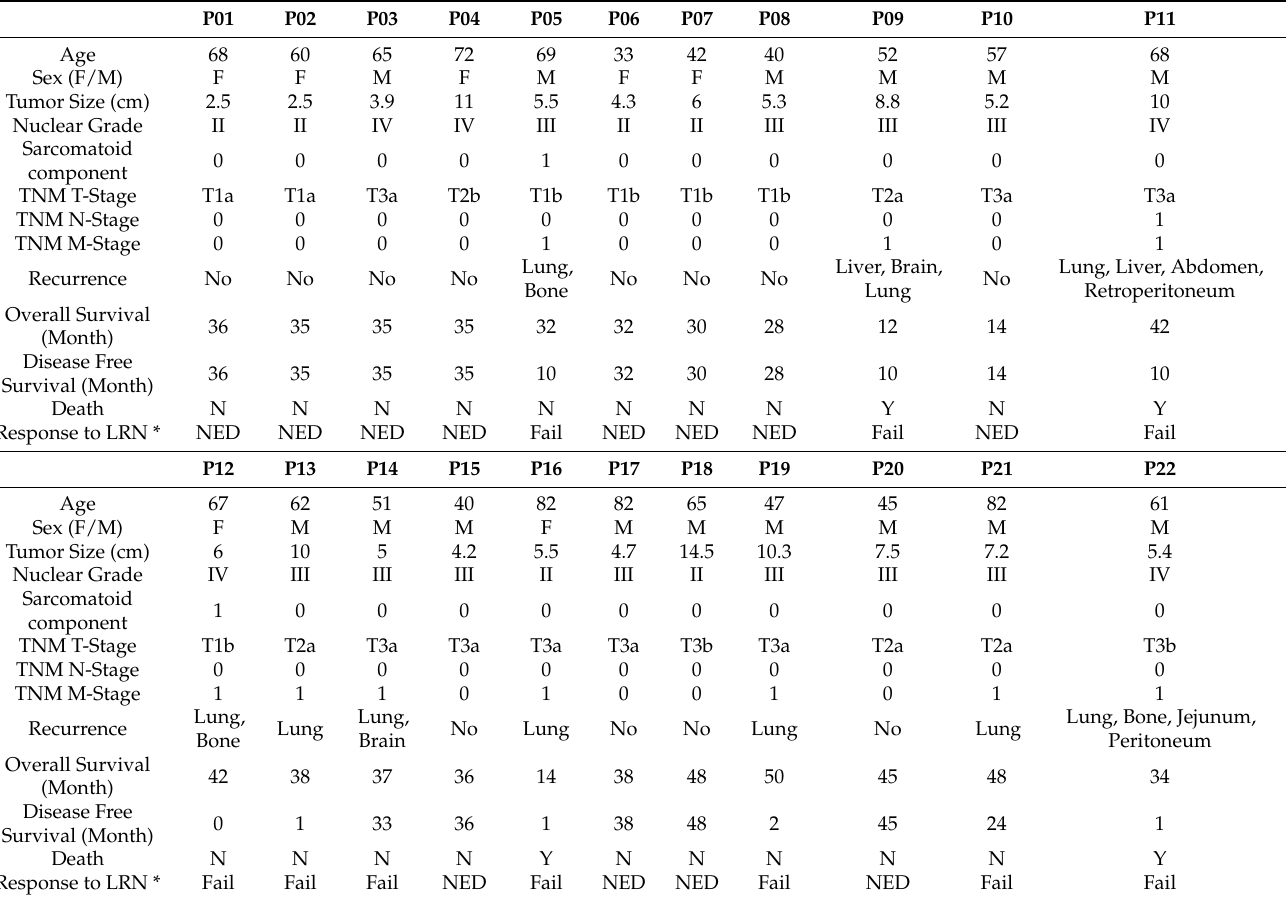
Table 1. Clinicopathological findings of 22 Korean patients with clear cell renal cell